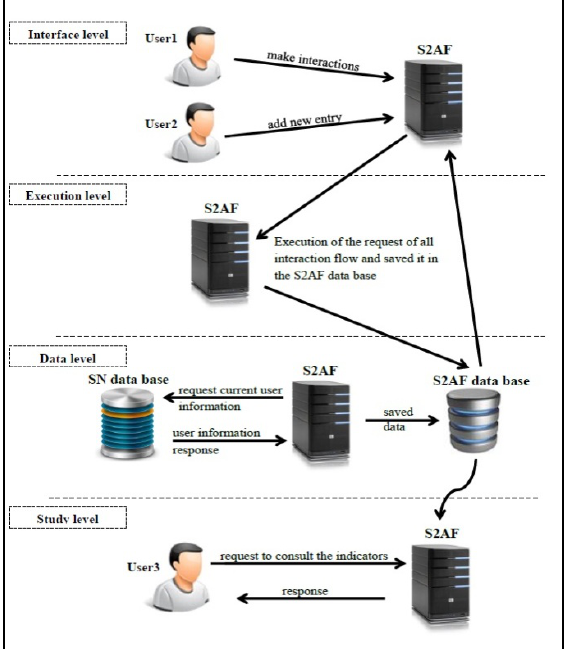
Figure.8. The architecture of S2AF